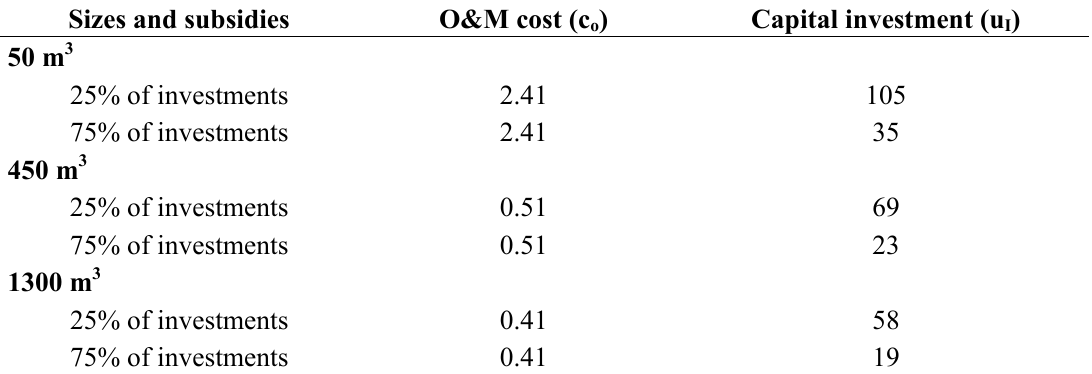
Table 3. Data for different sizes of rainwater systems with subsidies (RMB/m 3 ).